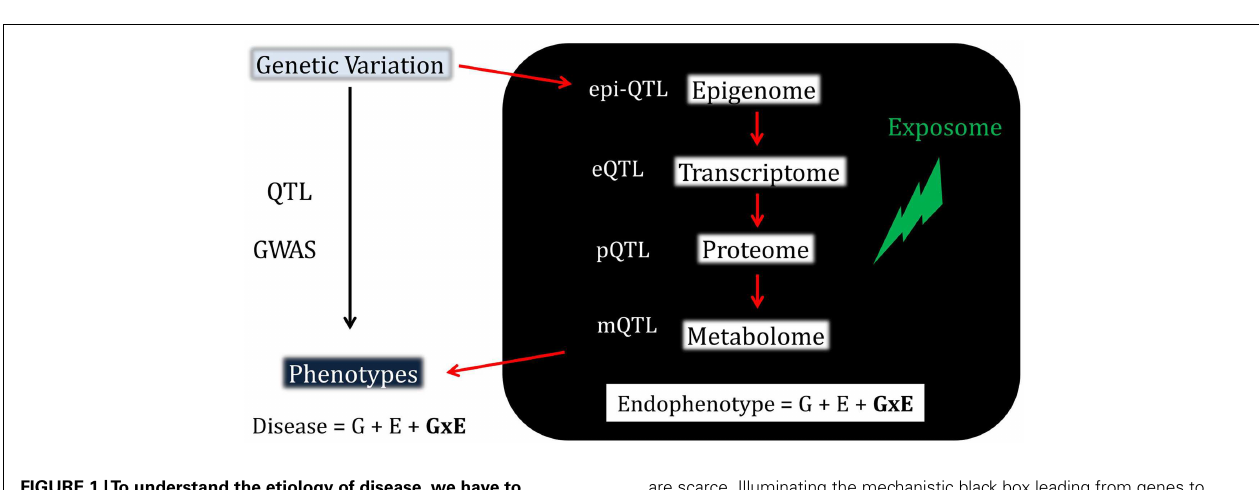
FIGURE 1 |To understand the etiology of disease, we have to understand how genotypic variation transduces into whole-organism phenotypic variation. Gene-environment interactions have long been recognized as a fundamental component of this process. However, robust demonstrations of gene-environment effects in humans